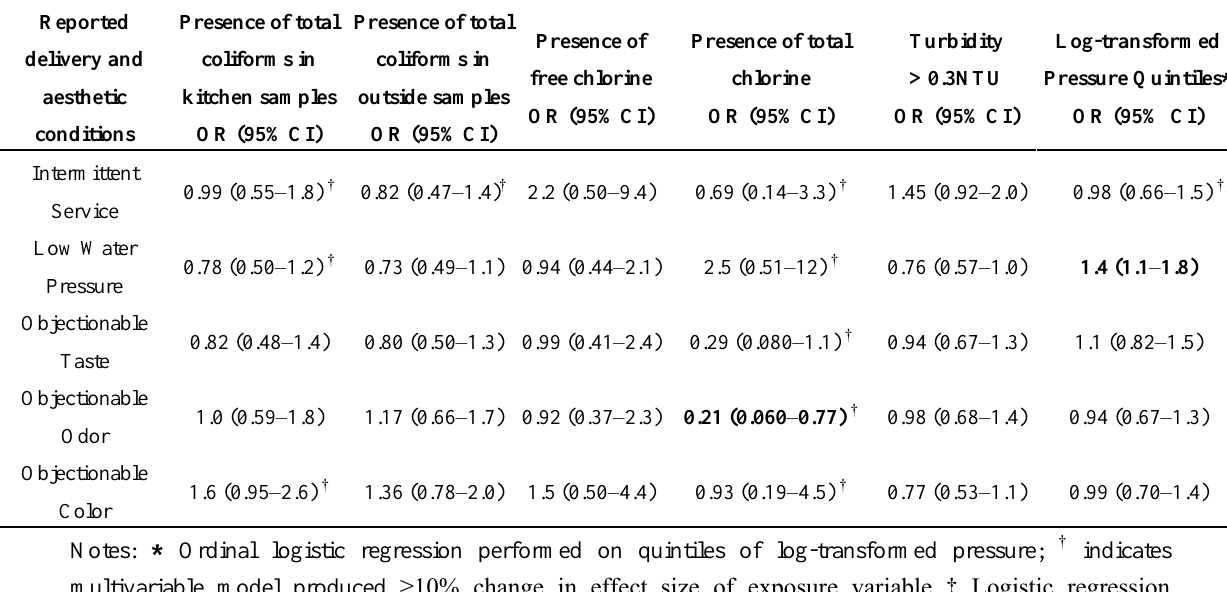
Table 5. Multivariable regression examining association between reported delivery and aesthetic conditions, sewerage and measured water quality in a sample of households of three rural counties in Alabama